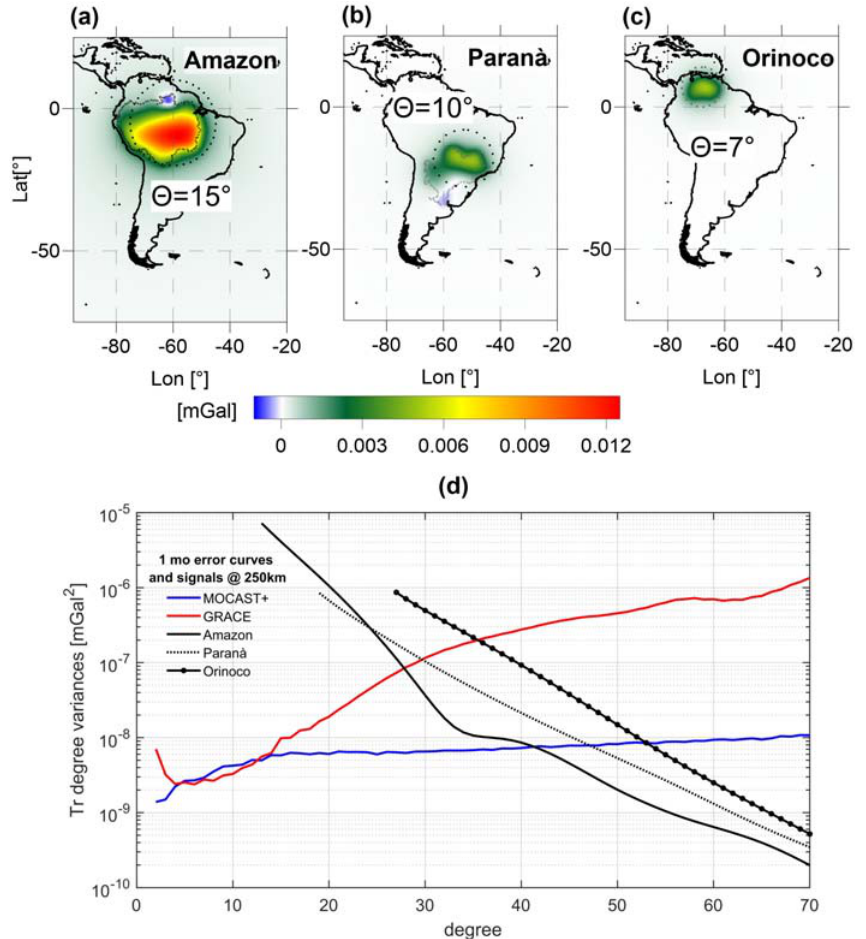
Figure 11. ( a – c ) Snapshot corresponding to the month when the maximum gravity of the seasonal amplitude was observed in the three basins considered and the outline of the caps used for the localized spectral analysis. Fields calculated at 250 km altitude. ( d ) Spectra of seasonal amplitude for 3 South American hydrologic basins (black lines). Monthly error curves of MOCAST+ (blue) and GRACE (red). Spectra calculated at 250 km